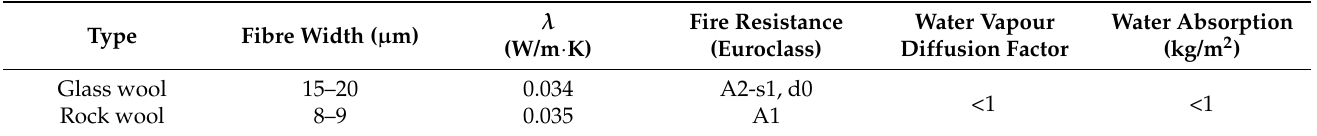
Table 3. Physical properties of the thermal insulation mineral wool waste used. (Source: adapted from URSA IBERICA, S.A.).